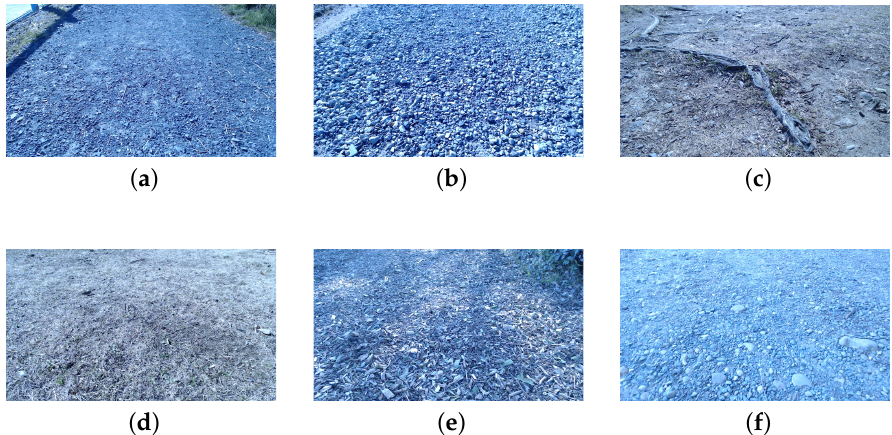
Figure 1. Natural terrains. ( a ) Gravel; ( b ) Stones; ( c ) Non-uniform; ( d ) Grass; ( e ) Woodchip; ( f )